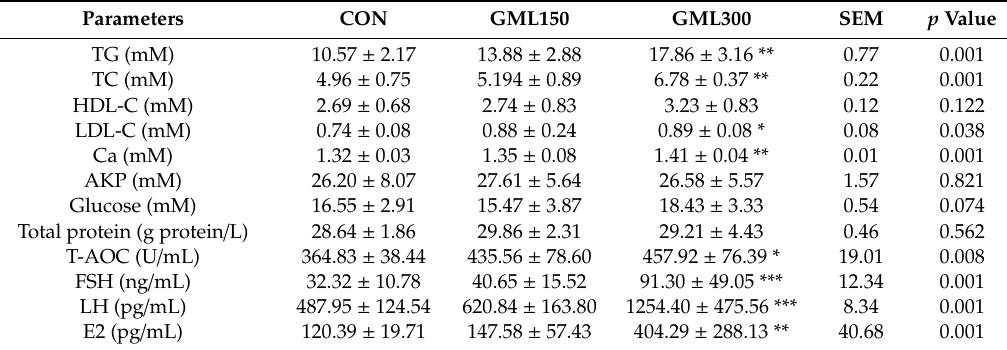
Table 2. E ff ect of dietary GML on serum parameters of late laying period hens.